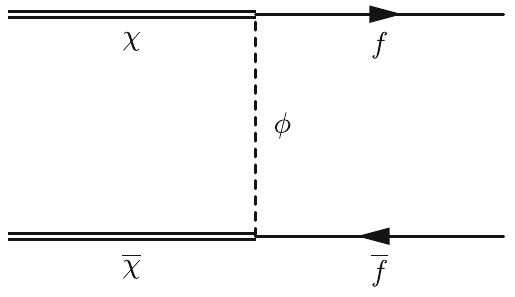
Fig. 1 A typical dark matter annihilation/scattering process